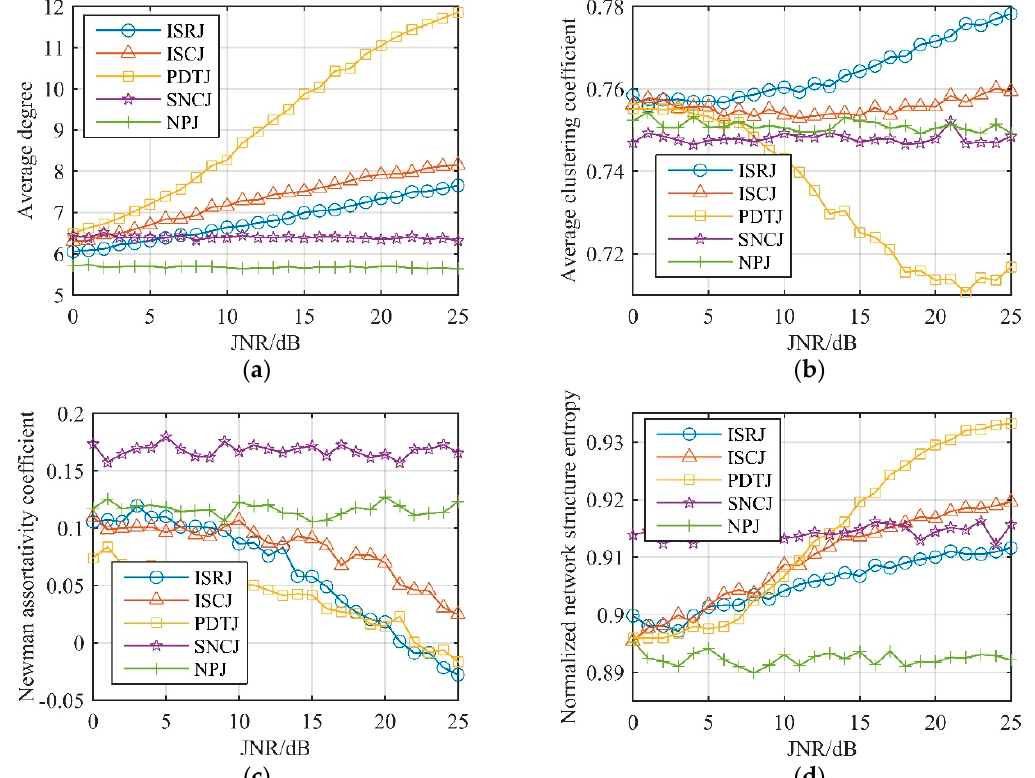
Figure 11. Related features of unconventional active jamming on visibility graphs. ( a ) Average degree; ( b ) average clustering coefficient; ( c ) Newman assortativity coefficient; ( d ) normalized network-structure entropy.